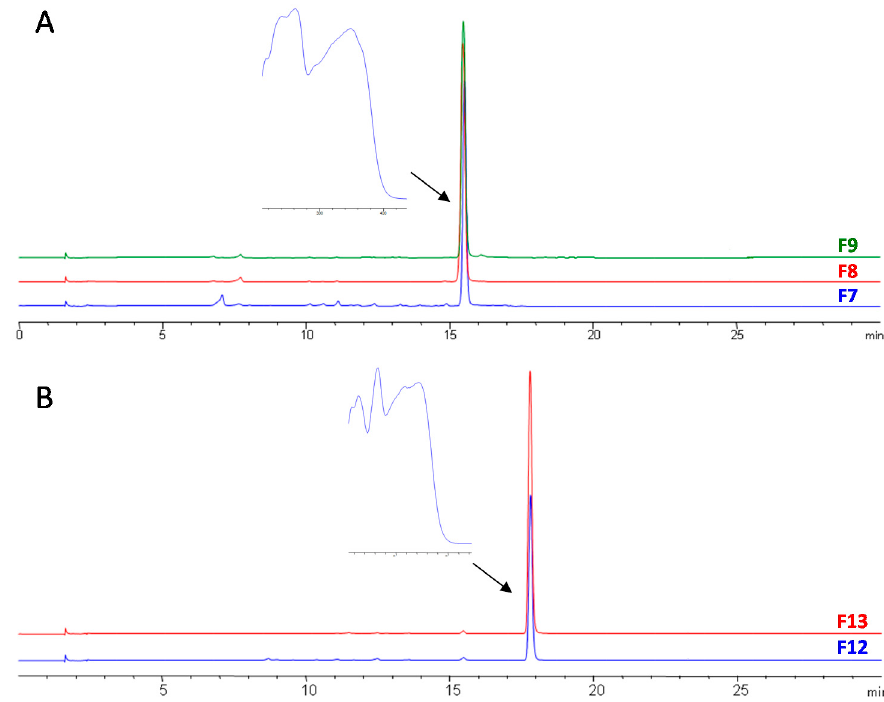
Figure 4. HPLC chromatograms obtained on a Luna C18(2) 100 Å column (150mm × 4.6 mm; 5 µm) at 254 nm, presenting the compositions of fractions F7 to F9 ( A ) and those of F12 and F13 ( B ).